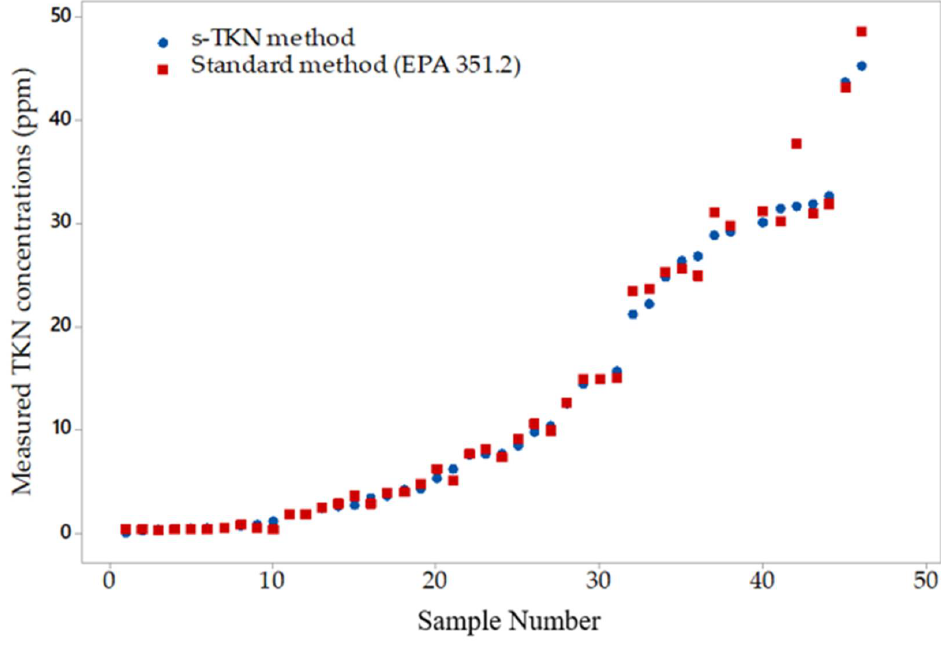
Figure 6. Comparison of Hach ® method and standard method on real-world